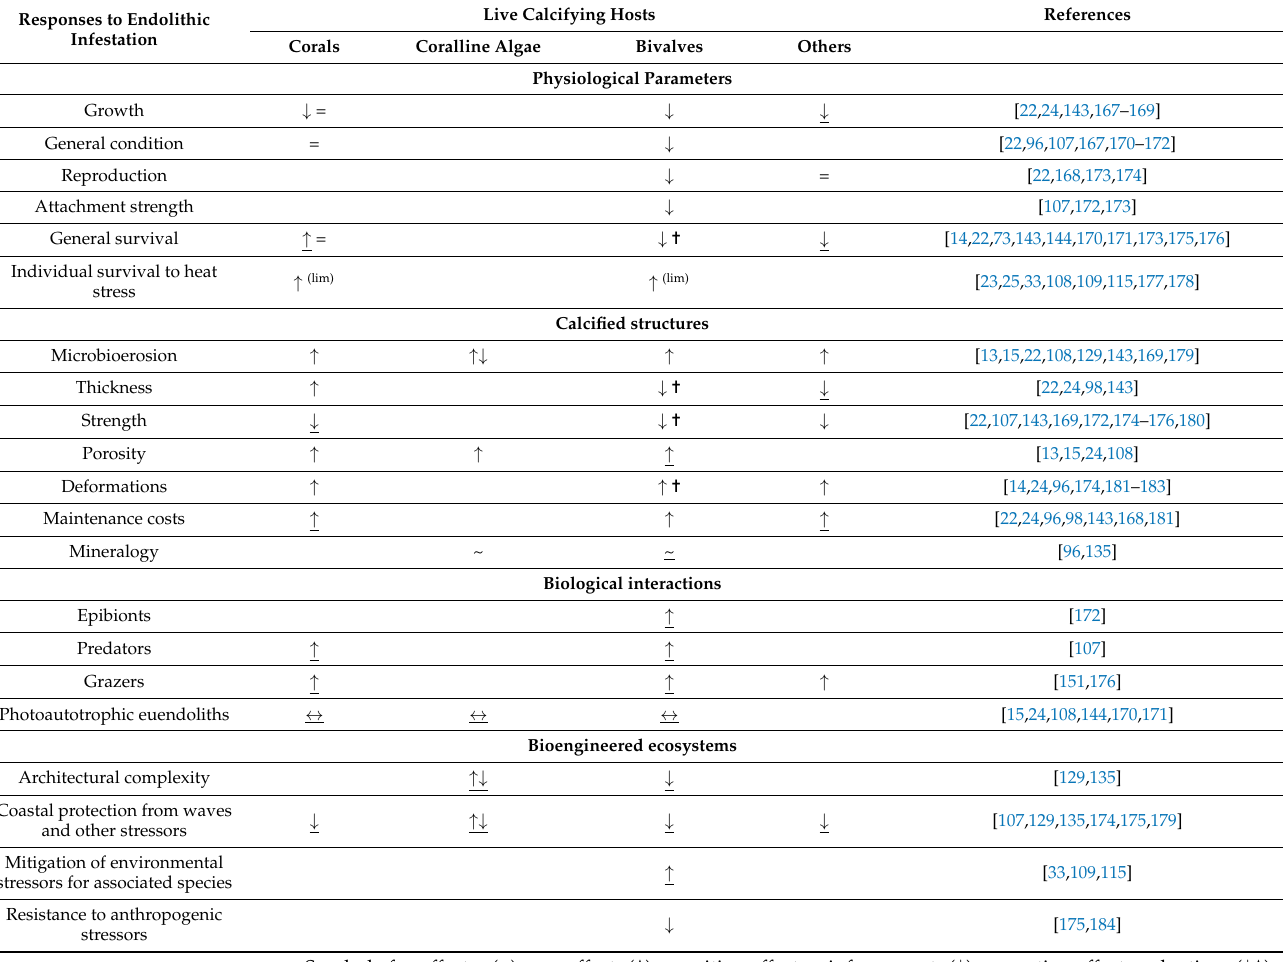
Table 1. Summary of the negative and positive effects observed and suspected (underlined) of euendolithic infestation on the physiological parameters, calcified structures, biological interactions, and bioengineering qualities of main live calcifying